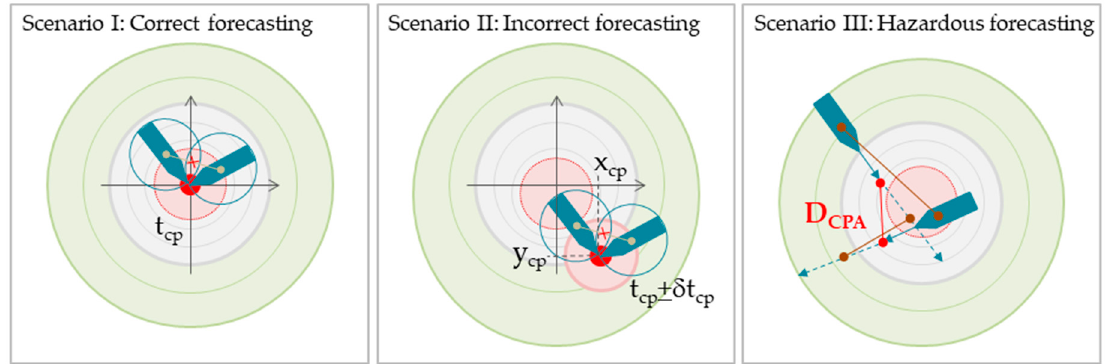
Figure 6. Impact of position, navigation and timing (PNT) data accuracy on the assessment of collision risk (collision area is marked with a red circle in case A and B; x cp and y cp —coordinates of collision point; D CPA —distance between both ships at the closest point of approach (CPA)).